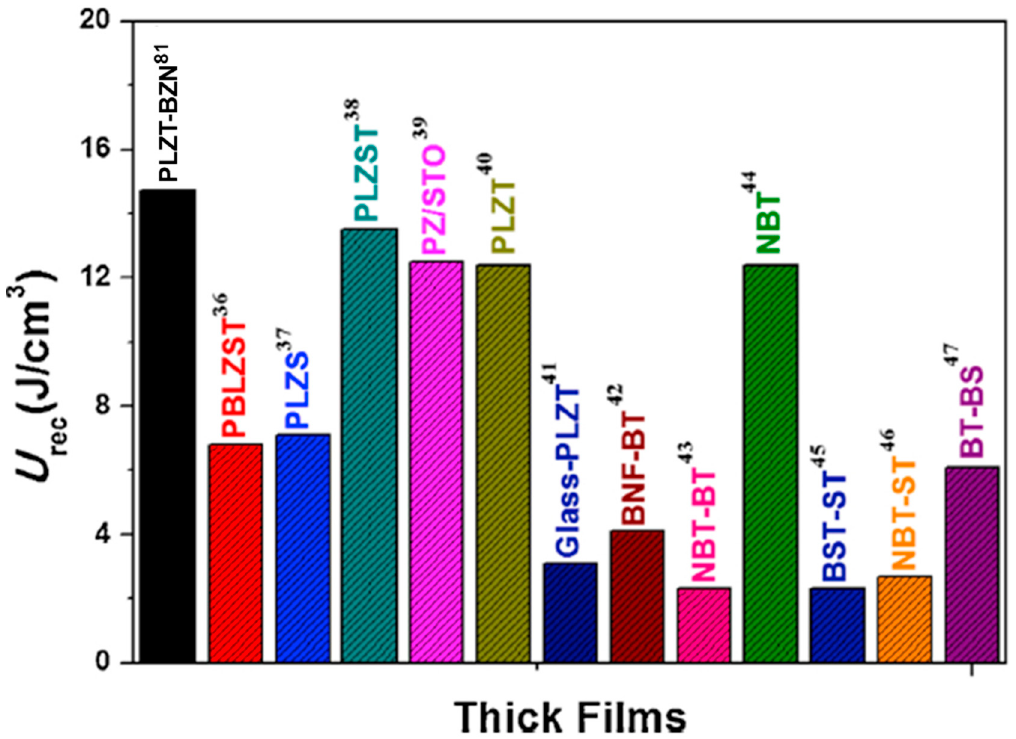
Figure 31. Comparison of U rec for AD-deposited Pb 0.92 La 0.08 Zr 0.52 Ti 0.48 O 3 - Bi(Zn 0.66 Nb 0.33 O 3 ) (PLZT-BZN) with other piezoelectric thick films [78]. © Copyright 2020, J. Eur. Ceram. Soc.